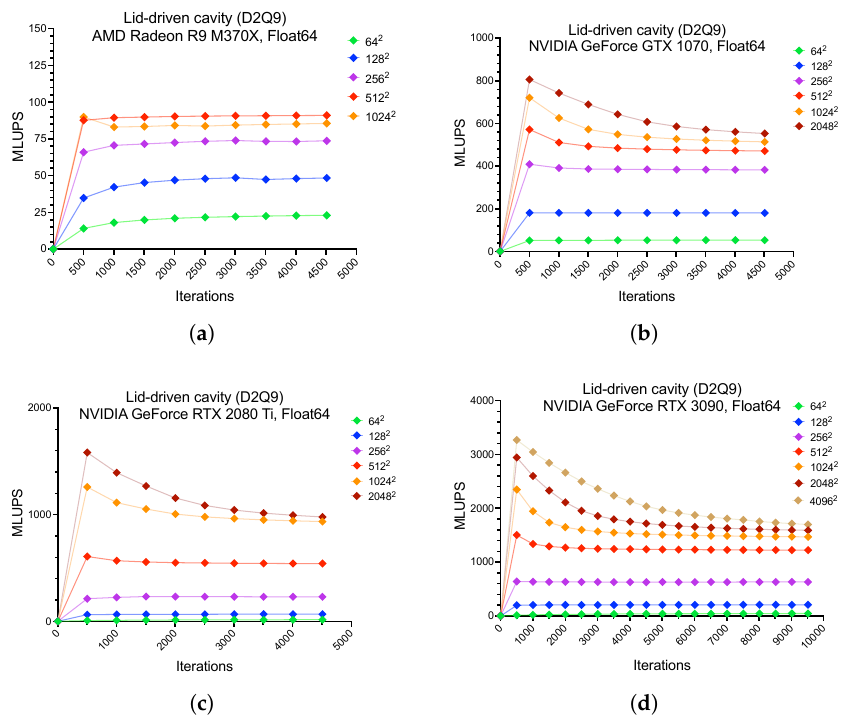
Figure 6. Double-precision performance analysis of 2D lid-driven cavity on D2Q9 stencil. ( a ) Perfor- mance on Radeon R9 M370X GPU; ( b ) Performance on GTX 1070 GPU; ( c ) Performance on RTX 2080 Ti GPU; ( d ) Performance on RTX 3090